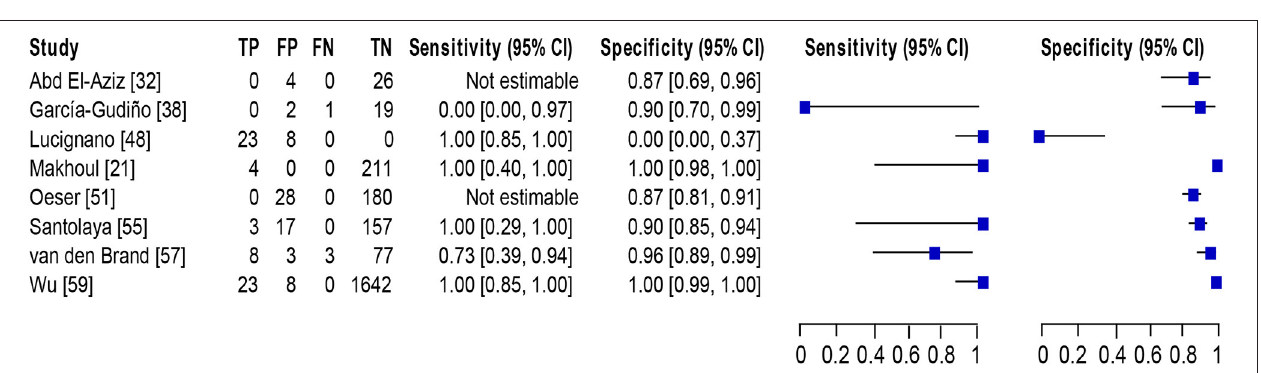
FIGURE 3 | Forest plot for detection of MSSA in the pediatric population. The square stands for the sensitivity and specificity of a particular study, the black line represents its confidence interval. TP, true positive, FP, false positive, FN, false negative, TN, true negative, CI, confidence